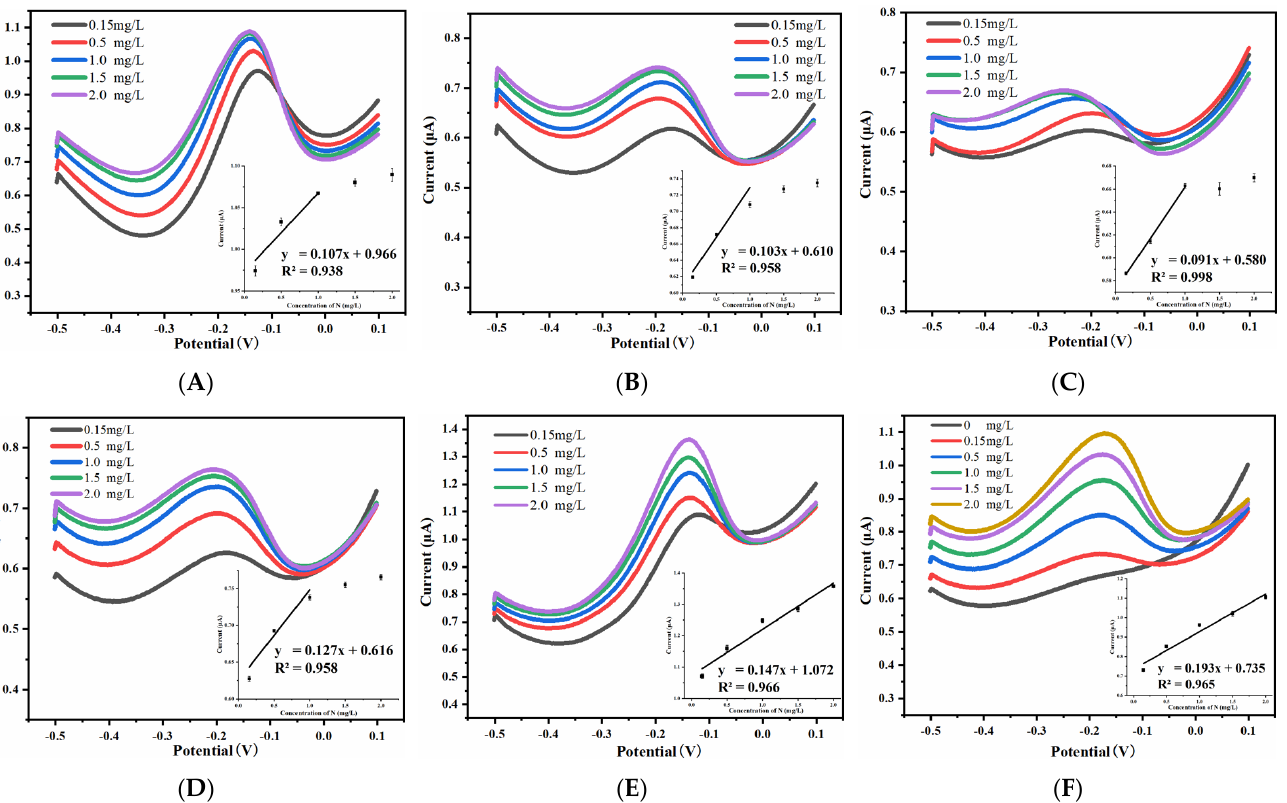
Figure 11. DPV response curves and the calibration curves (inset) of UIAE chips for NH 3 -N with different spacing-to-width ratios: ( A ) 15; ( B ) 13; ( C ) 11; ( D ) 9; ( E ) 7; ( F ) 5. Table 1. Results of NH 3 -N detection using UIAE with various spacing-to-width ratios and widths. Spacing-To-Width Detection Range Sensitivity Width ( μ m) Ratio (mg/L) ( μ A·L·mg − 1 )